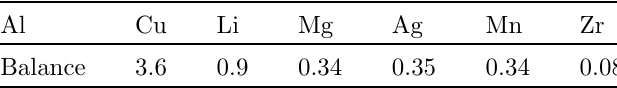
Table 1. Main chemical composition of AA2050 (wt%).